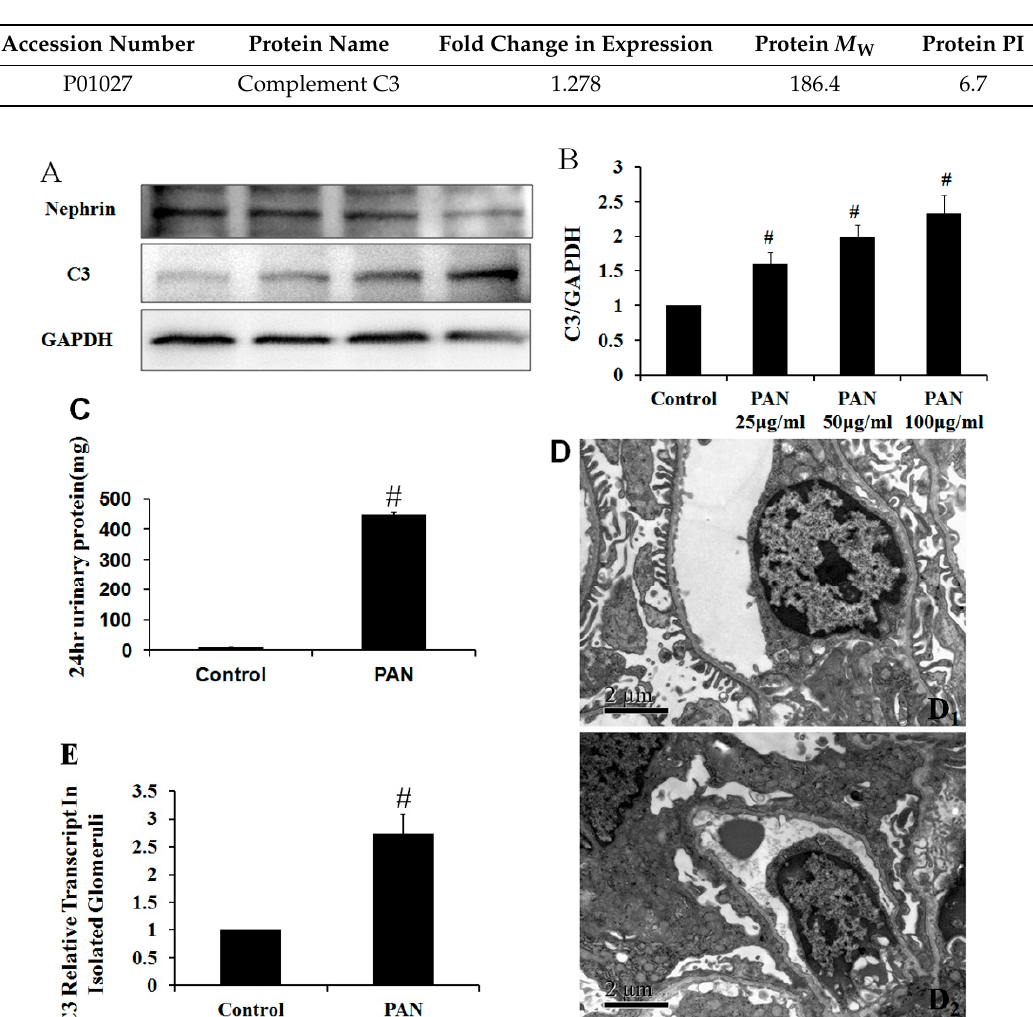
Table 2. List of significantly differentially-expressed proteins identified by iTRAQ analysis of PAN-induced podocyte injury.